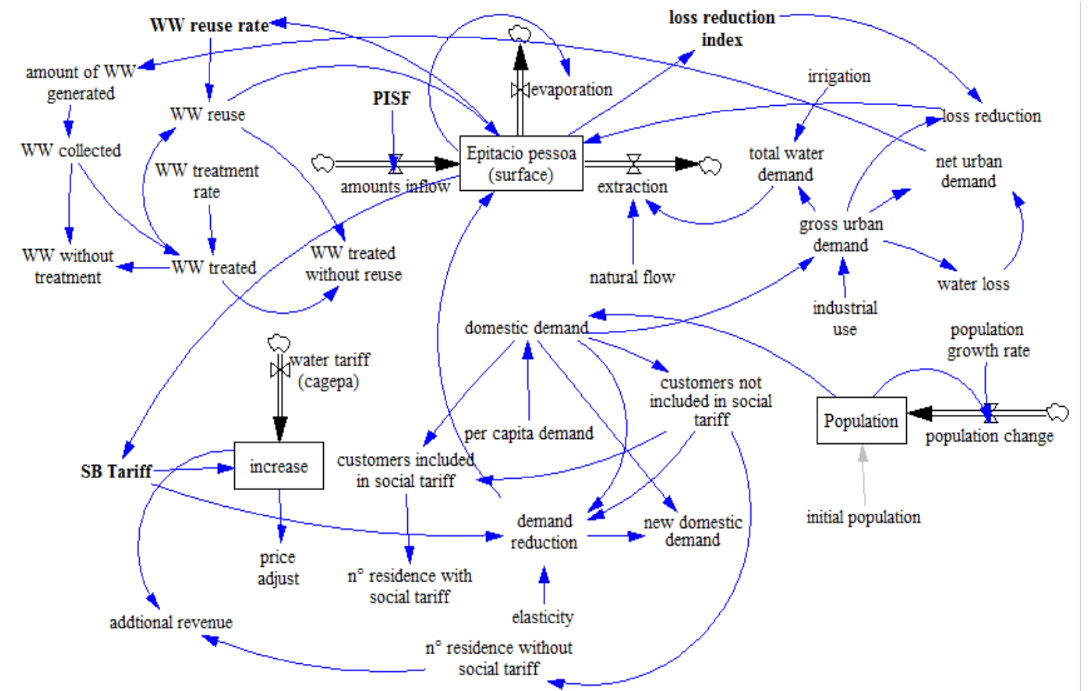
Figure 6. Stock and flow diagram to represent the model